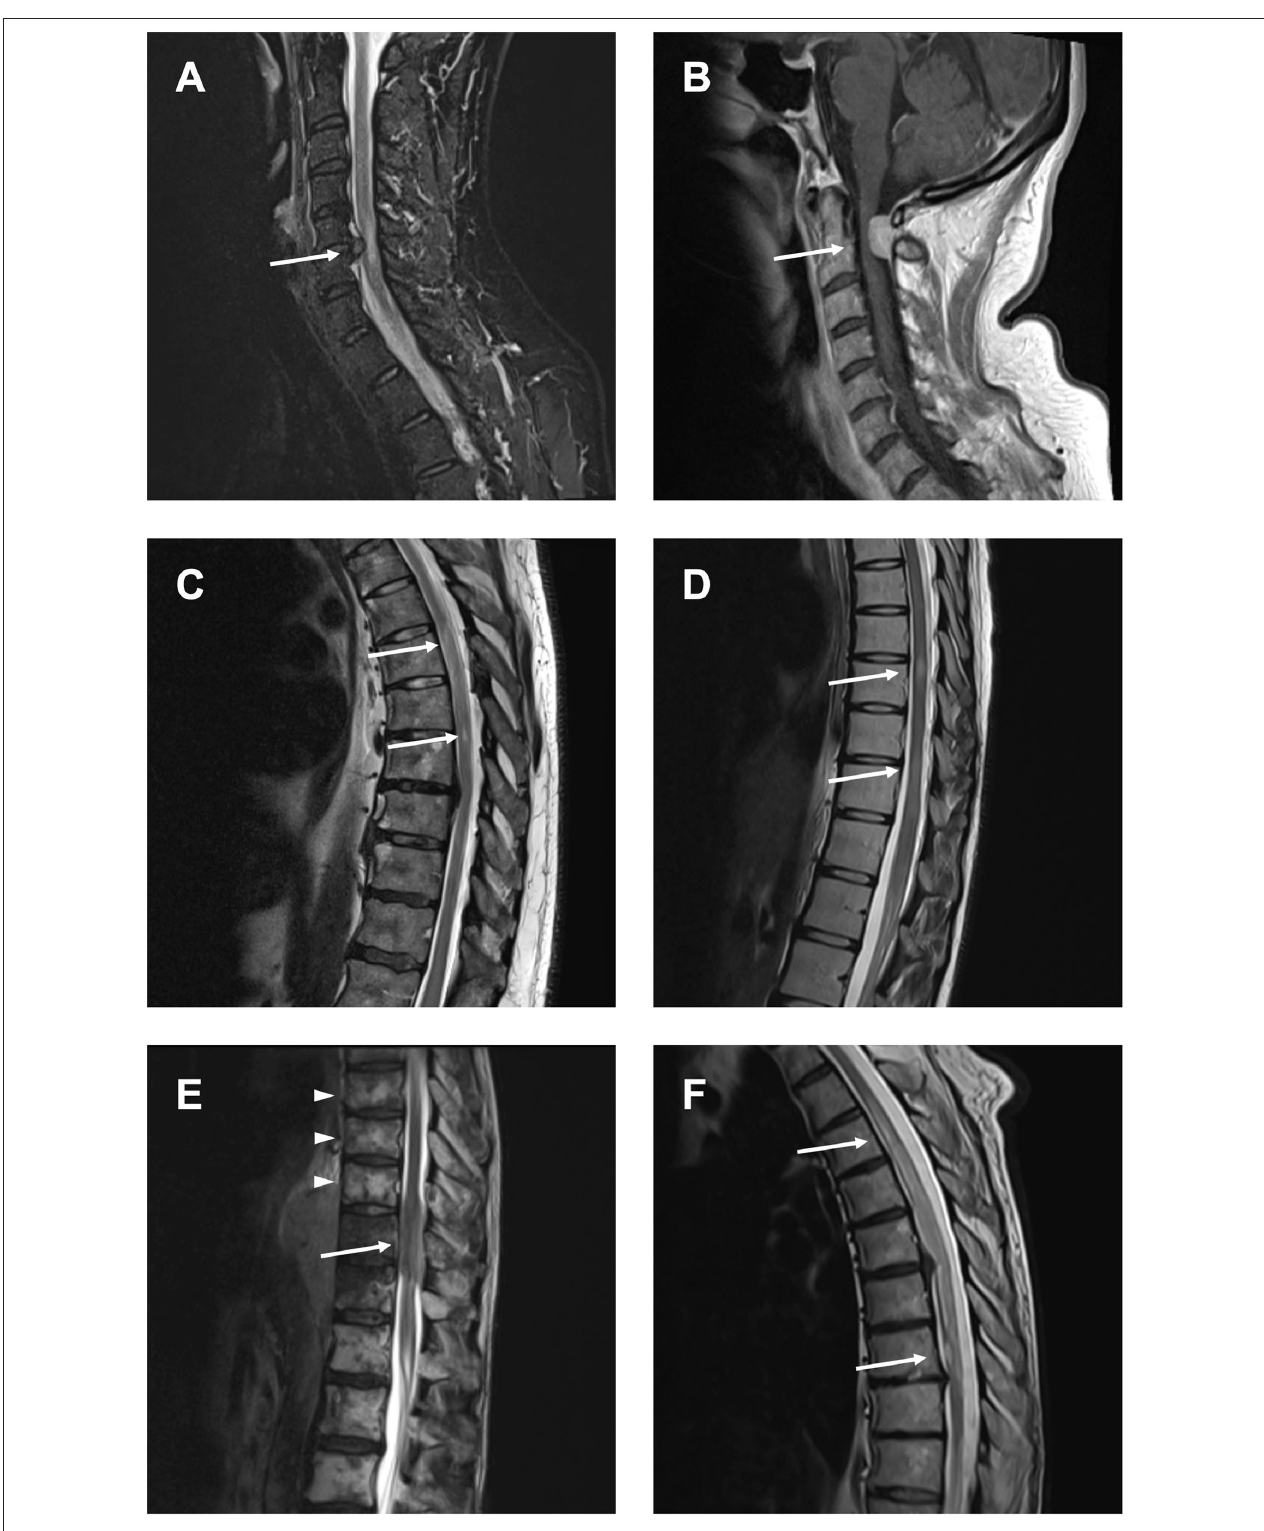
FIGURE 4 | Compressive and non-compressive myelopathies causing NTSCI. (A) Compressive myelopathy due to cervical spinal stenosis. (B) Compressive myelopathy due to spinal meningioma. (C) Myelopathy due to spinal cord ischemia. (D) Spinal lesions in multiple sclerosis. (E) Spinal metastasis (arrow) and vertebral metastases (arrowheads) in a patient with lymphoma. (F) Leptomeningeal carcinomatosis in a patient with non-small cell lung cancer (NSCLC).